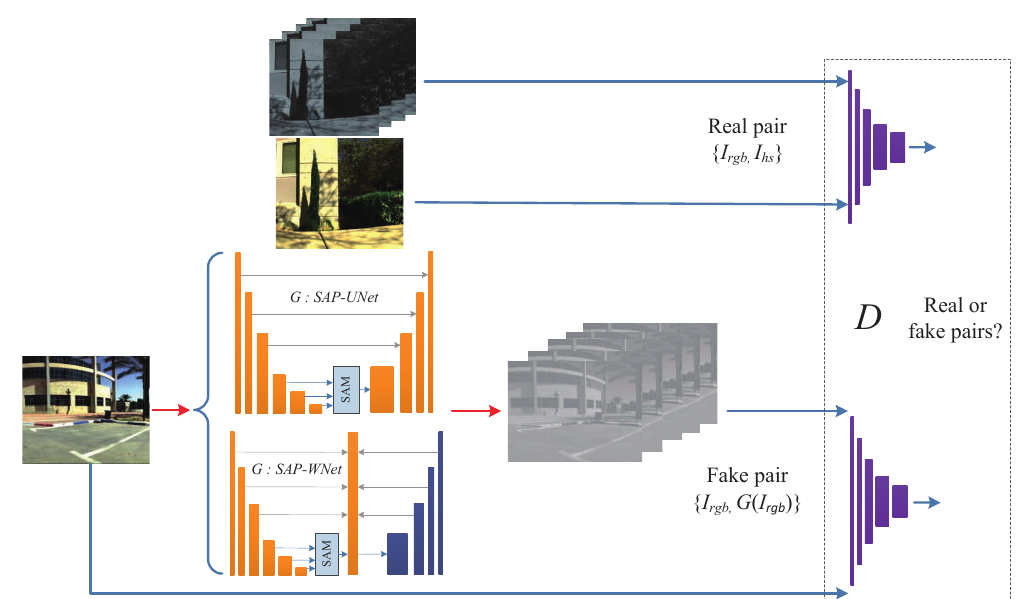
Figure 1. Overview of our two adversarial feature pyramid spectral reconstruction models. SAM, scale attention